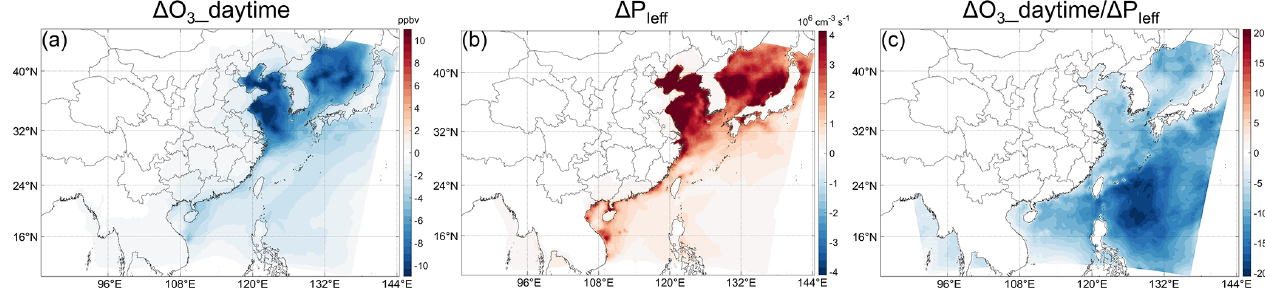
Figure 9. Iodine-chemistry-induced change in (a) daytime (LT 08:00–16:00) O 3 concentration and (b) production rate of the effective iodine atom (iodine atom that can consume O 3 , including all reactions that can produce the iodine atom except IO photolysis and reactions which produce NO 2 ; ≈ O 3 loss rate by local iodine chemistry). (c) The ratio between (a) and (b) , only for qualitative illustration. The large negative values in the Philippine Sea of (c) indicate the large “excessive” decrease in O 3 compared to its local